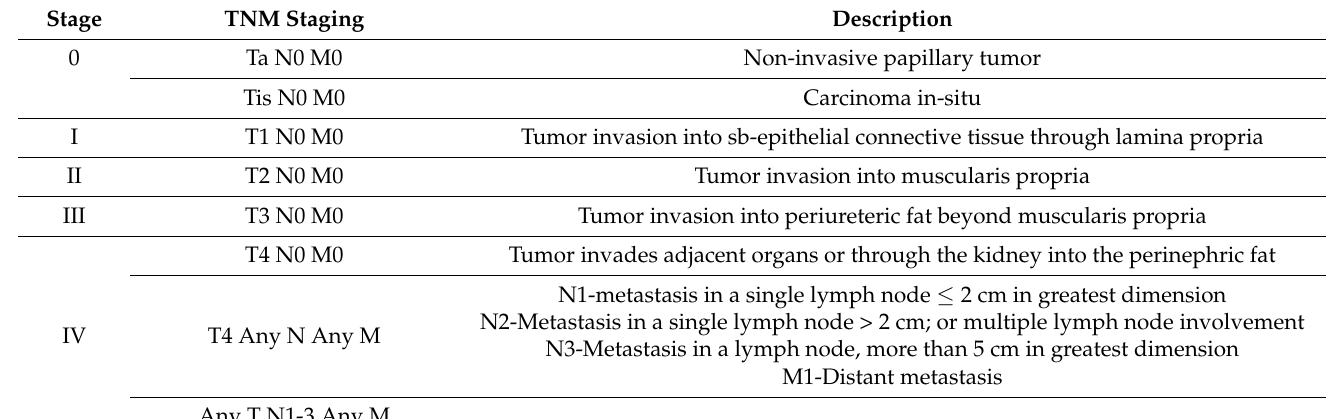
Table 9. TNM staging of ureteral malignancies [123].